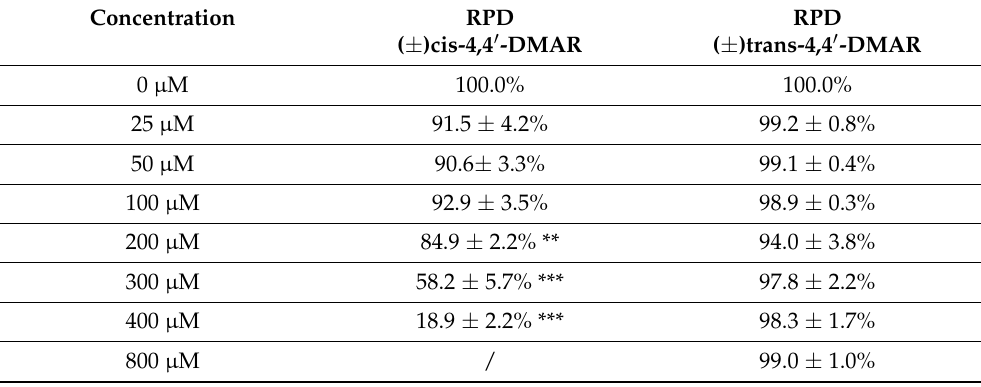
Table 1. RPD of TK6 cells after 26 h treatment with ( ± )cis-4,4 (cid:48) -DMAR or ( ± )trans-4,4 (cid:48) -DMAR at the indicated concentrations compared to the concurrent negative control [0 µ M]. Each value represents the mean ± SEM of three independent experiments. Data were analysed using one-way repeated measures ANOVA followed by Dunnet as post-test. ** p < 0.01 vs. [0 µ M]; *** p < 0.001 vs. [0 µ M]. The red line separates the RPDs complying or not with the OECD threshold for cellular replication (45 ± 5%).